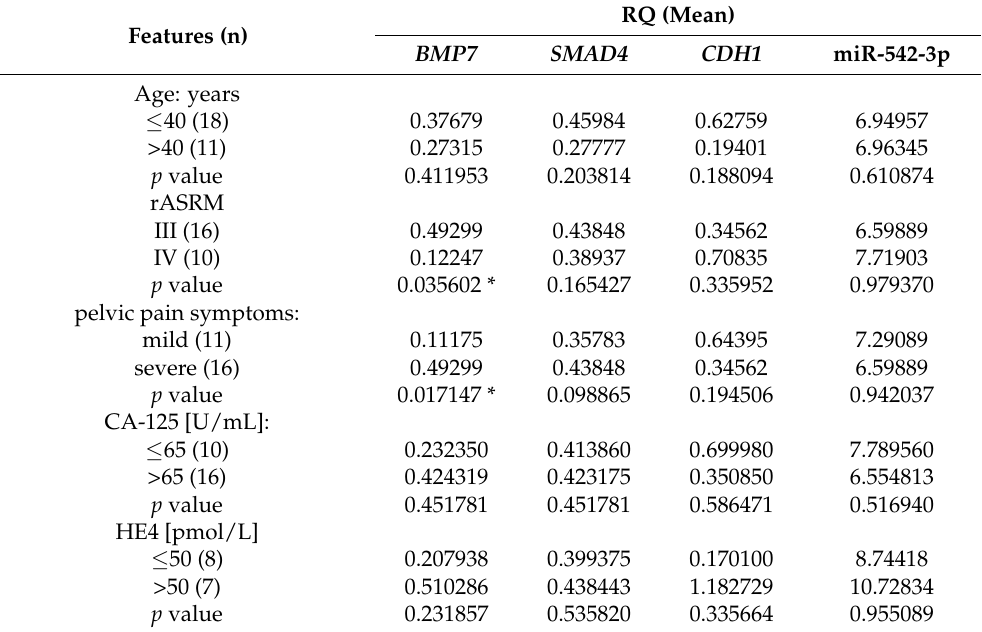
Table 2. Expression levels (mean RQ value) of study genes and miRNA in ectopic tissue in relation to clinical features and biochemical parameters of patients with